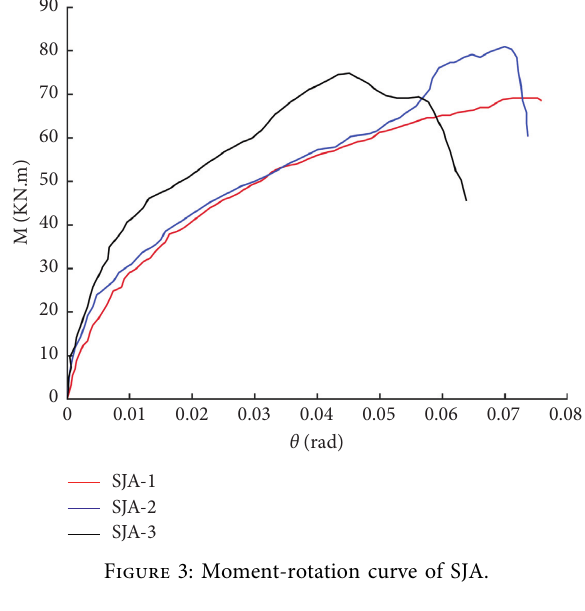
Figure 3: Moment-rotation curve of SJA.